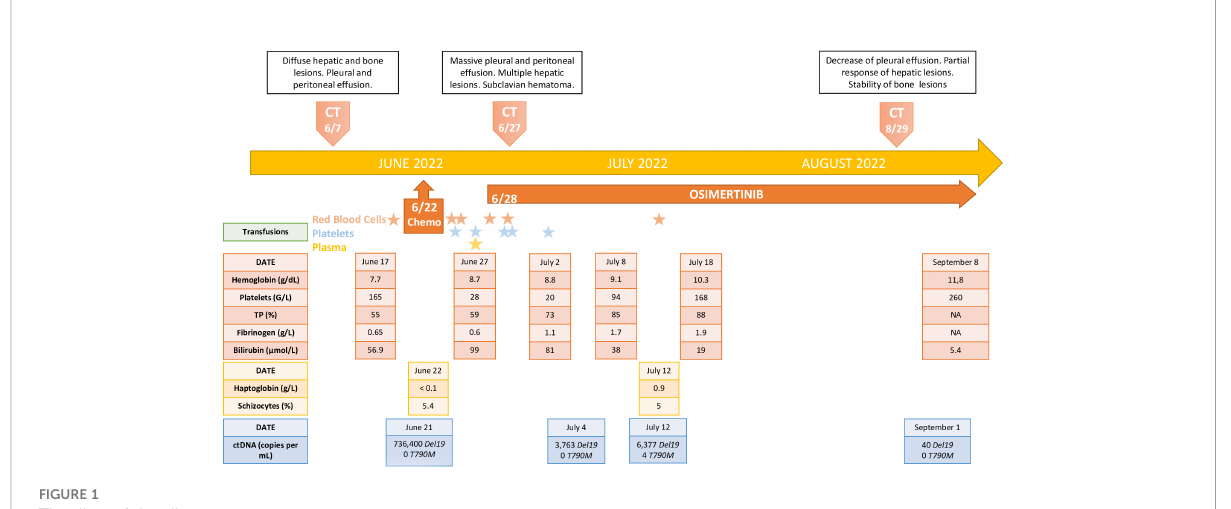
FIGURE 1 Timeline of the disease